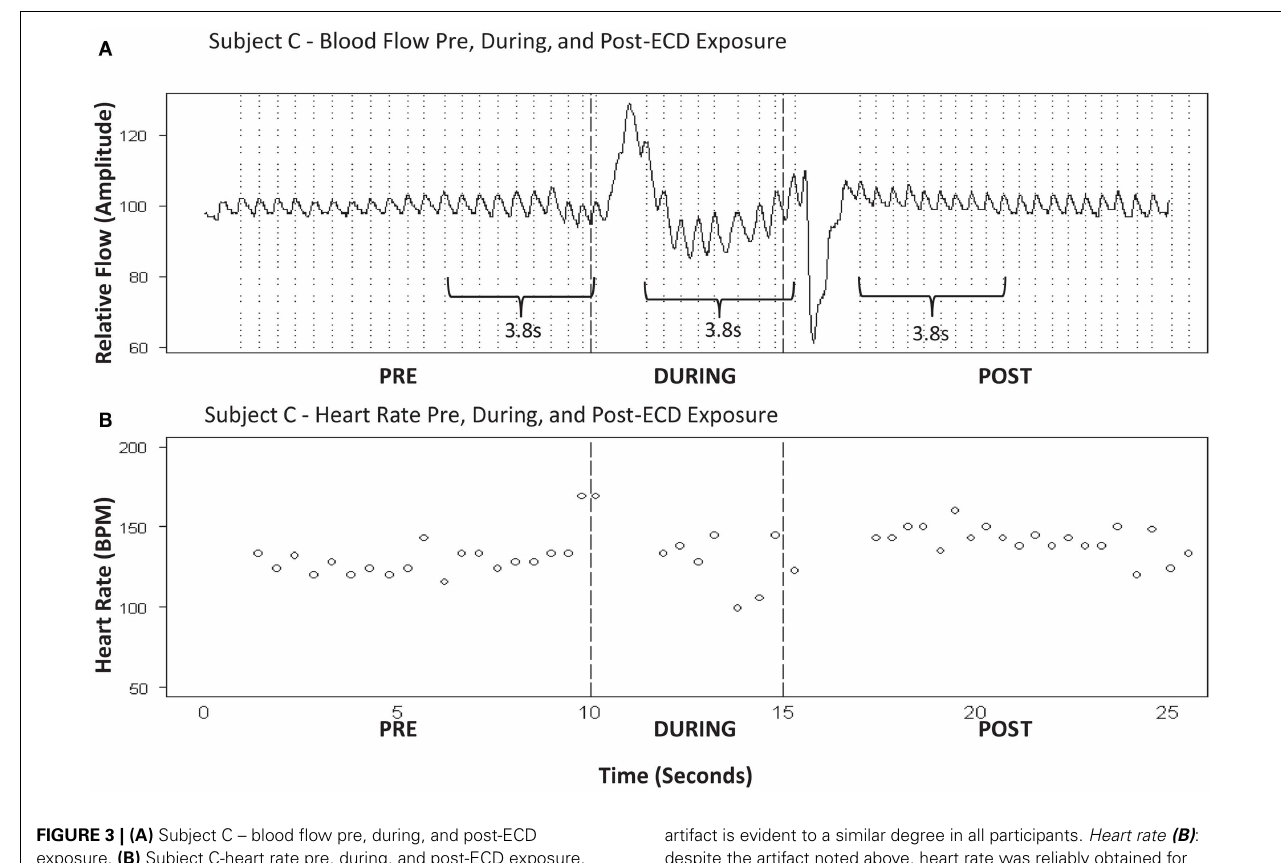
FIGURE 3 | (A) Subject C – blood flow pre, during, and post-ECD exposure. (B) Subject C-heart rate pre, during, and post-ECD exposure. Blood flow (A) : example of the processed PPG waveform for 10-sprior to ECD exposure, through the 5-s exposure, and for 10-s following exposure. Note that dramatic flow artifact is evident immediately upon ECD exposure and immediately upon the cessation of exposure;